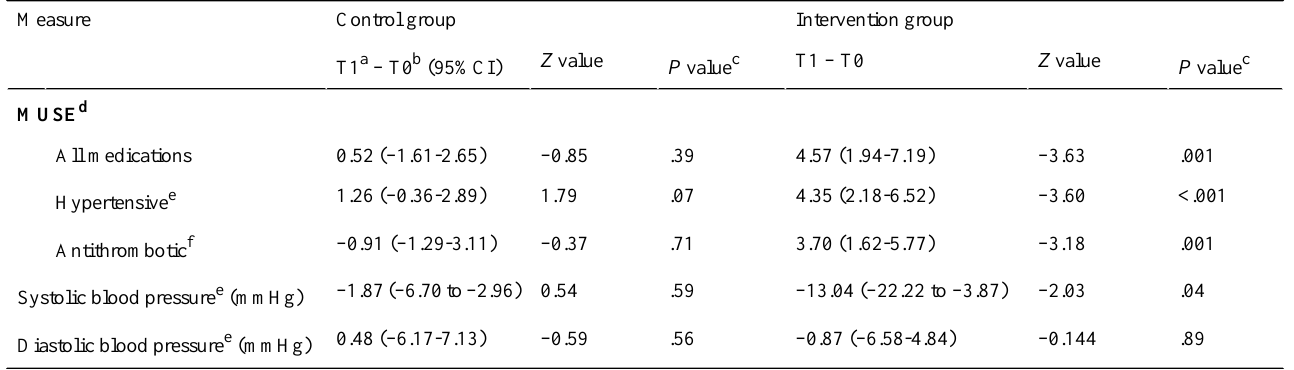
Table 3. Comparison of outcome measurement within groups.